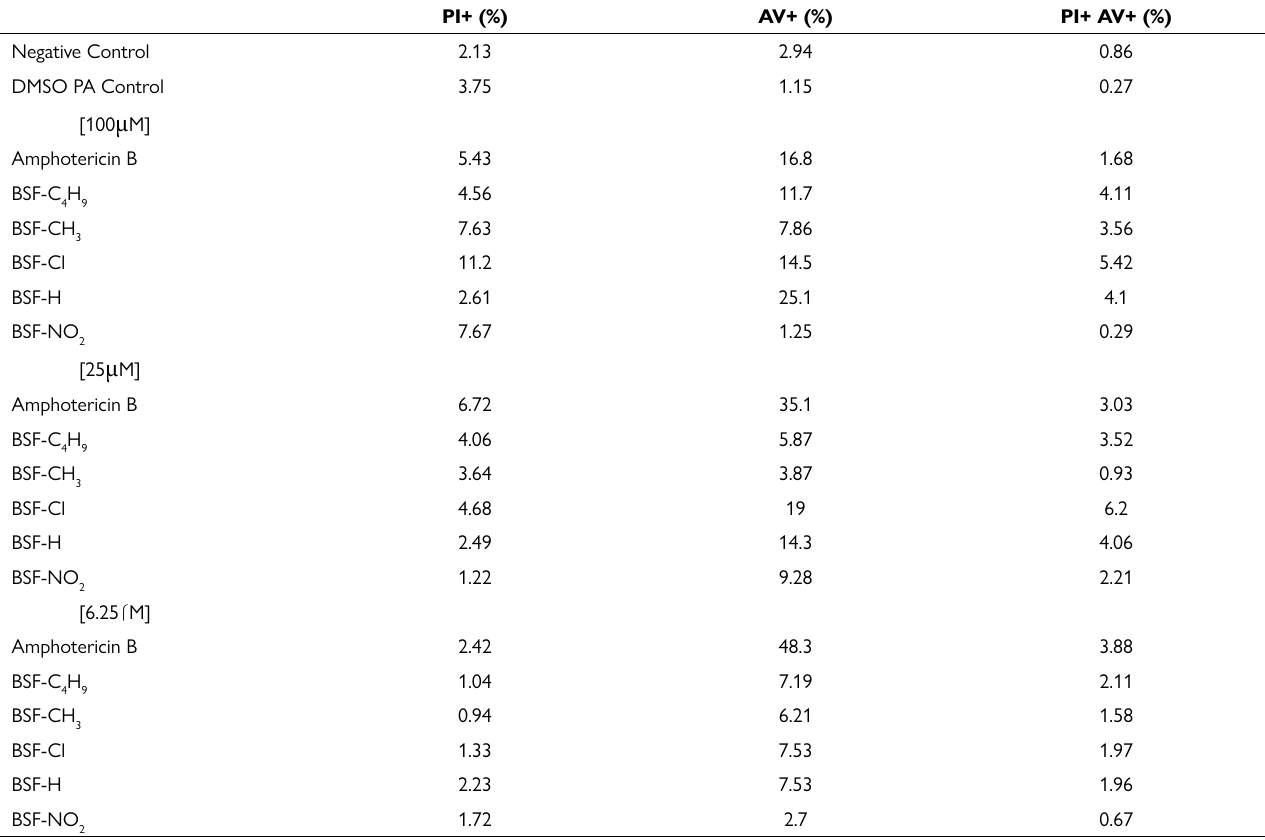
Table 2 Detection of phosphatidylserine expression by Annexin V method on L.(L) amazonensis promatigotes exposed to different concentrations of nitro- heterocyclic derivatives and amphotericin